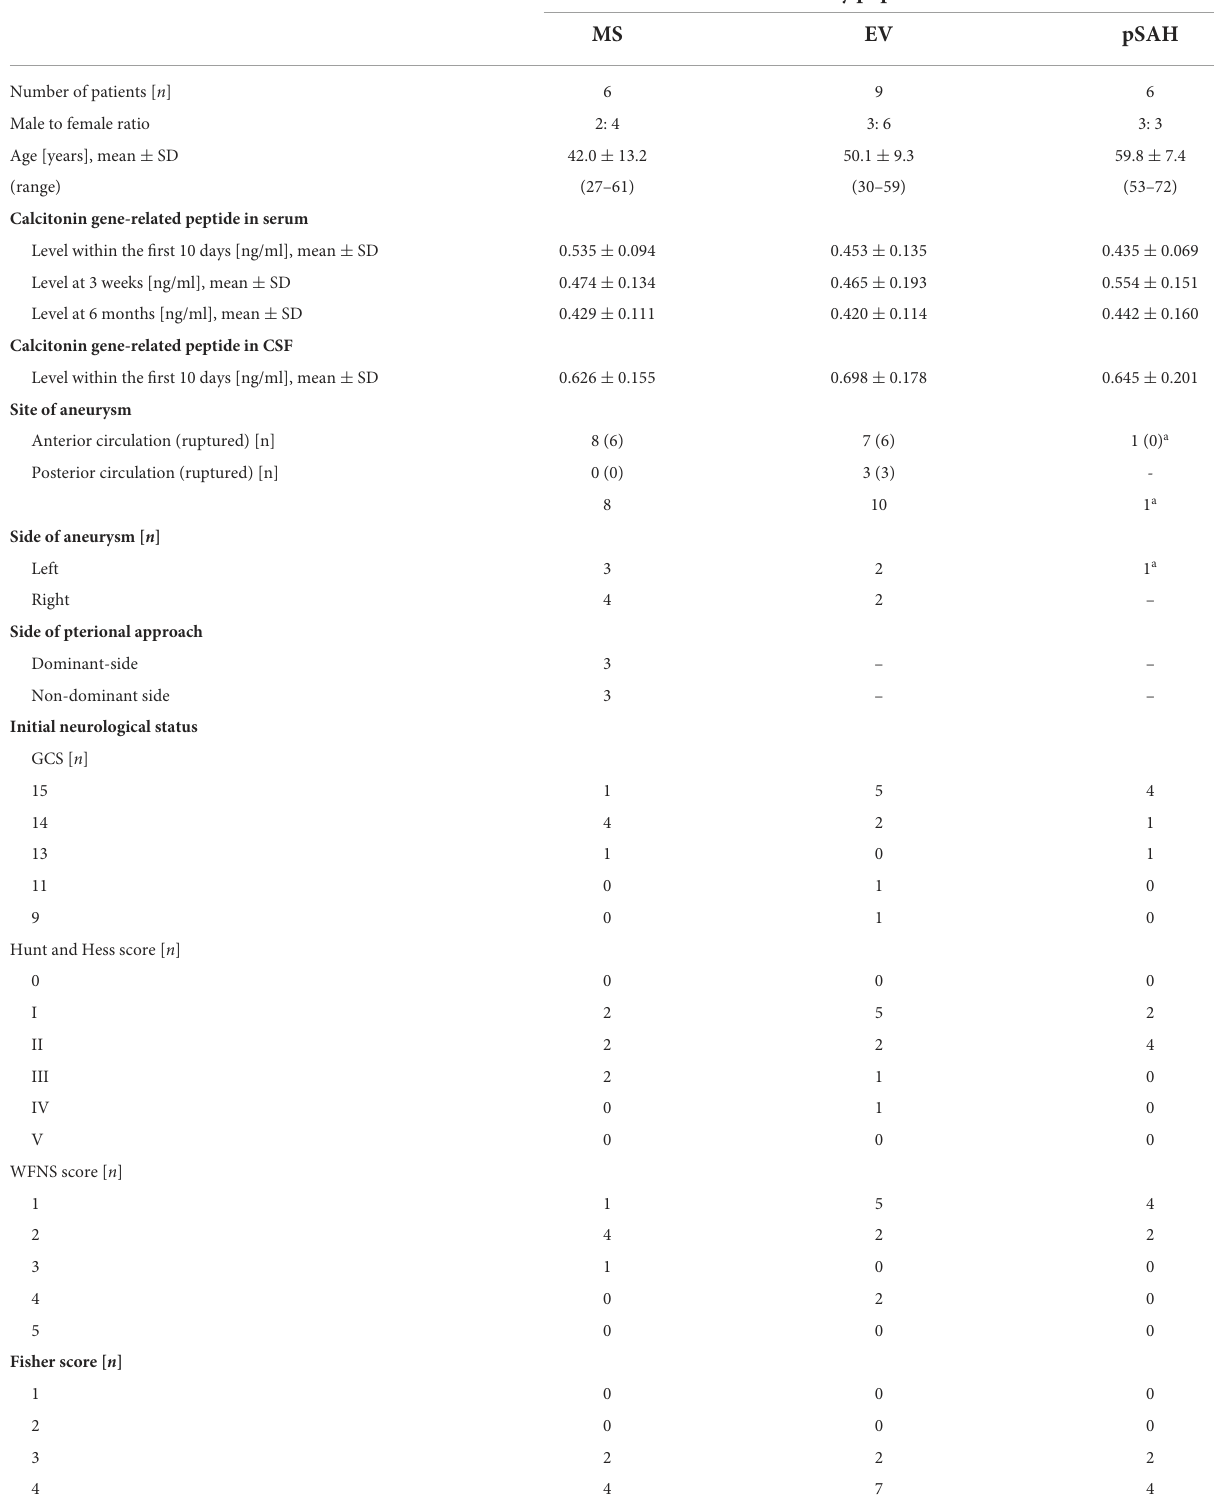
TABLE 1 Demographic and clinical characteristics of